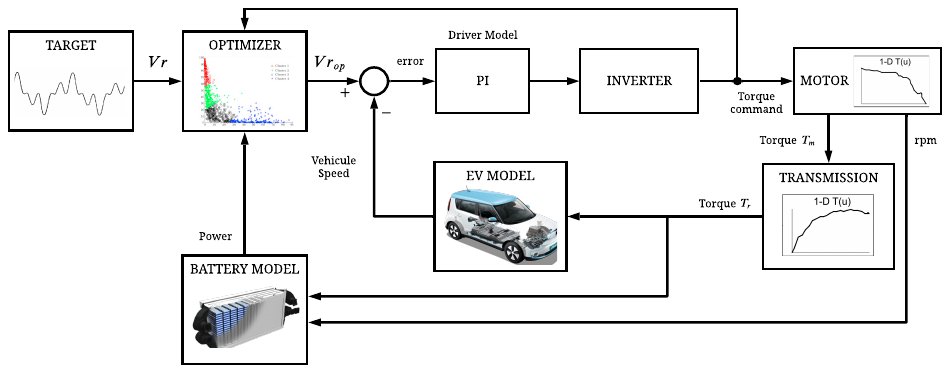
Figure 8. Simulation schematic to optimization for drive